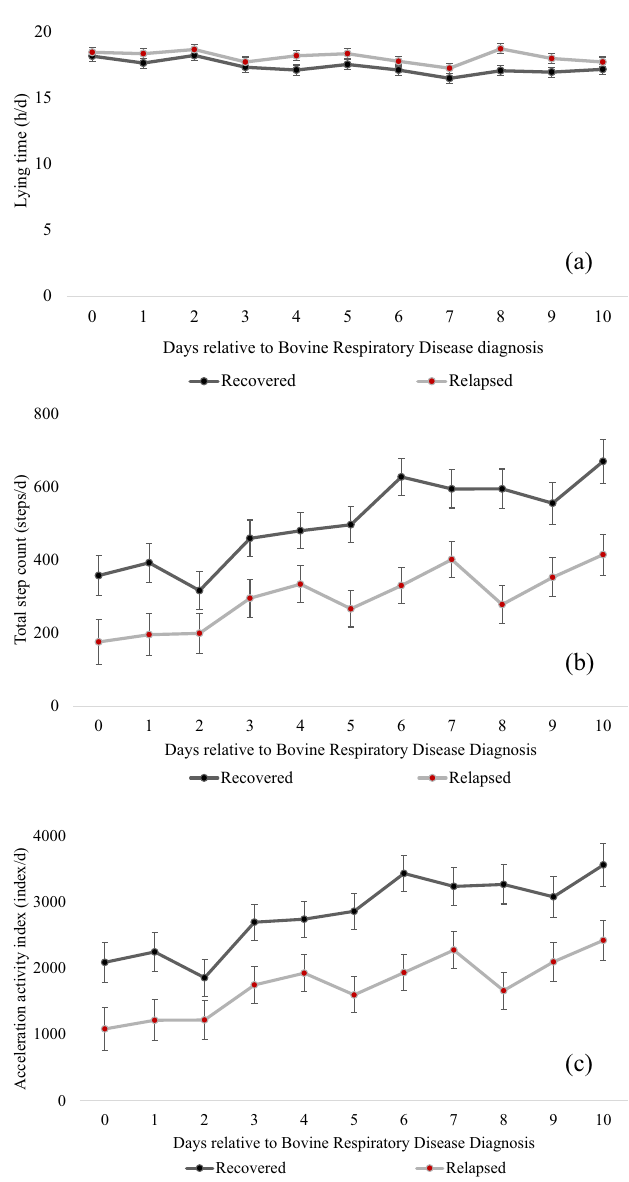
Figure 1. The association of recovery status 1 with lying time ( a ), total step count ( b ) and acceleration index ( c ) (LSM ± SEM) for the day of diagnosis (day 0) and the 10 days after antimicrobial intervention for Bovine Respiratory Disease for preweaned, pair-matched calves (n = 19 pairs) offered 10 L of milk replacer/day by an automated feeder. 1 Bovine respiratory disease (BRD) status was defined as a clinical score on Wisconsin Scoring system and lobar lung consolidation ≥ 3 cm 2 and all calves were treated for BRD on day 0. Recovery status was defined as calves that either resolved symptoms of BRD within 10 days post-antimicrobial treatment (recovered) or had clinical BRD status from days 10–14 (relapsed). Significant differences by day are not